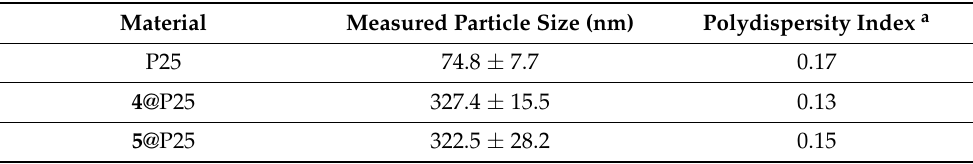
Table 3. The particle size distribution of P25, 4 @P25, and 5 @P25.